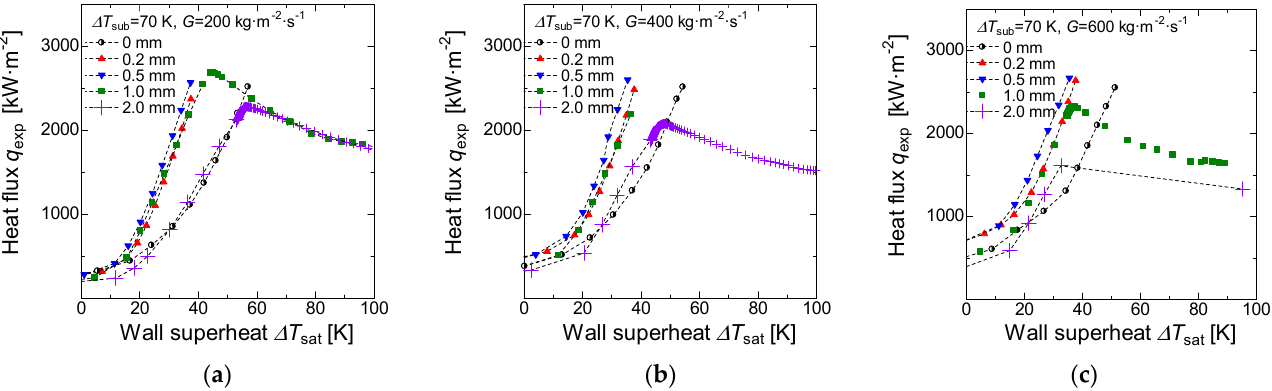
Figure 6. Maximum heat flux for all the porous thickness, inlet subcooling temperature ∆ T sub = 70 K: ( a ) G = 200 kg · m − 2 · s − 1 , ( b ) G = 400 kg · m − 2 · s − 1 , ( c ) G = 600 kg · m − 2 · s − 1